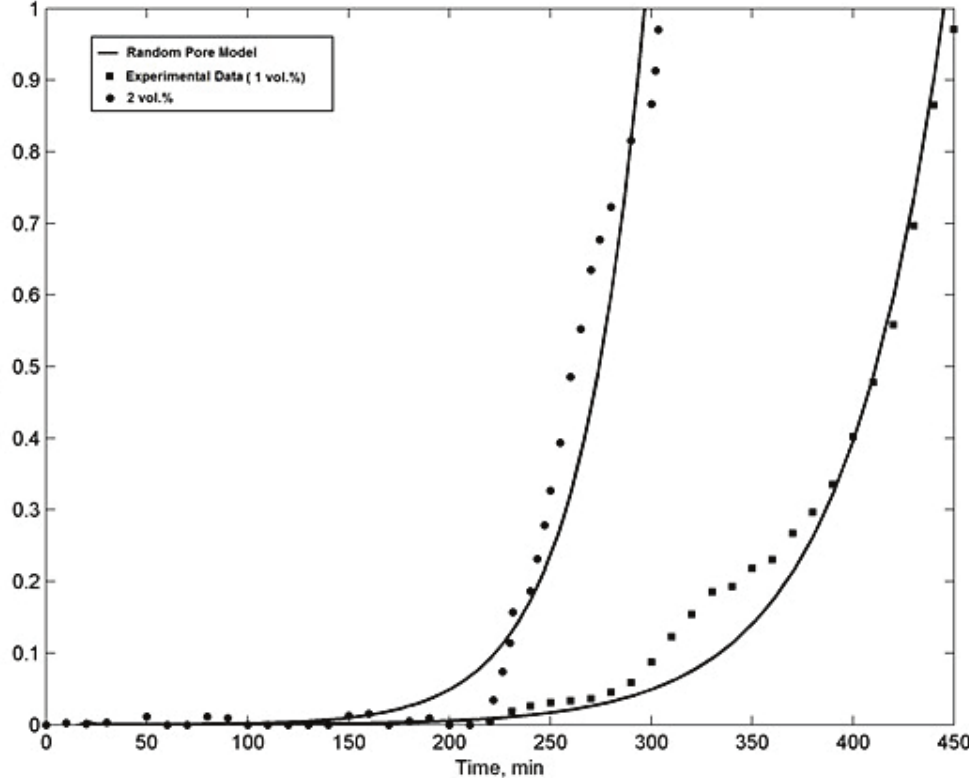
breakthrough curves from MgO packed bed reactor 2 2